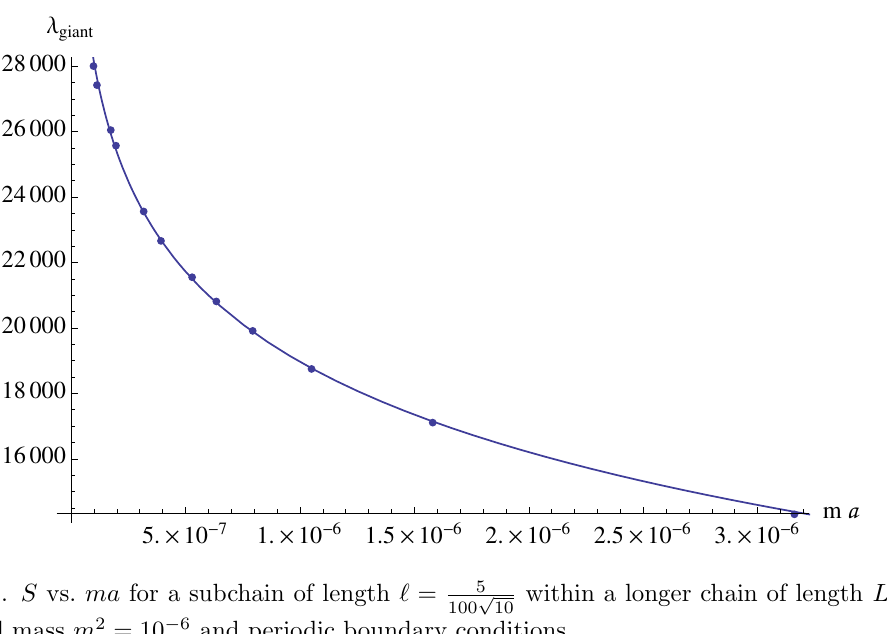
within a longer chain of length L = 10 ‘ , p 100 10